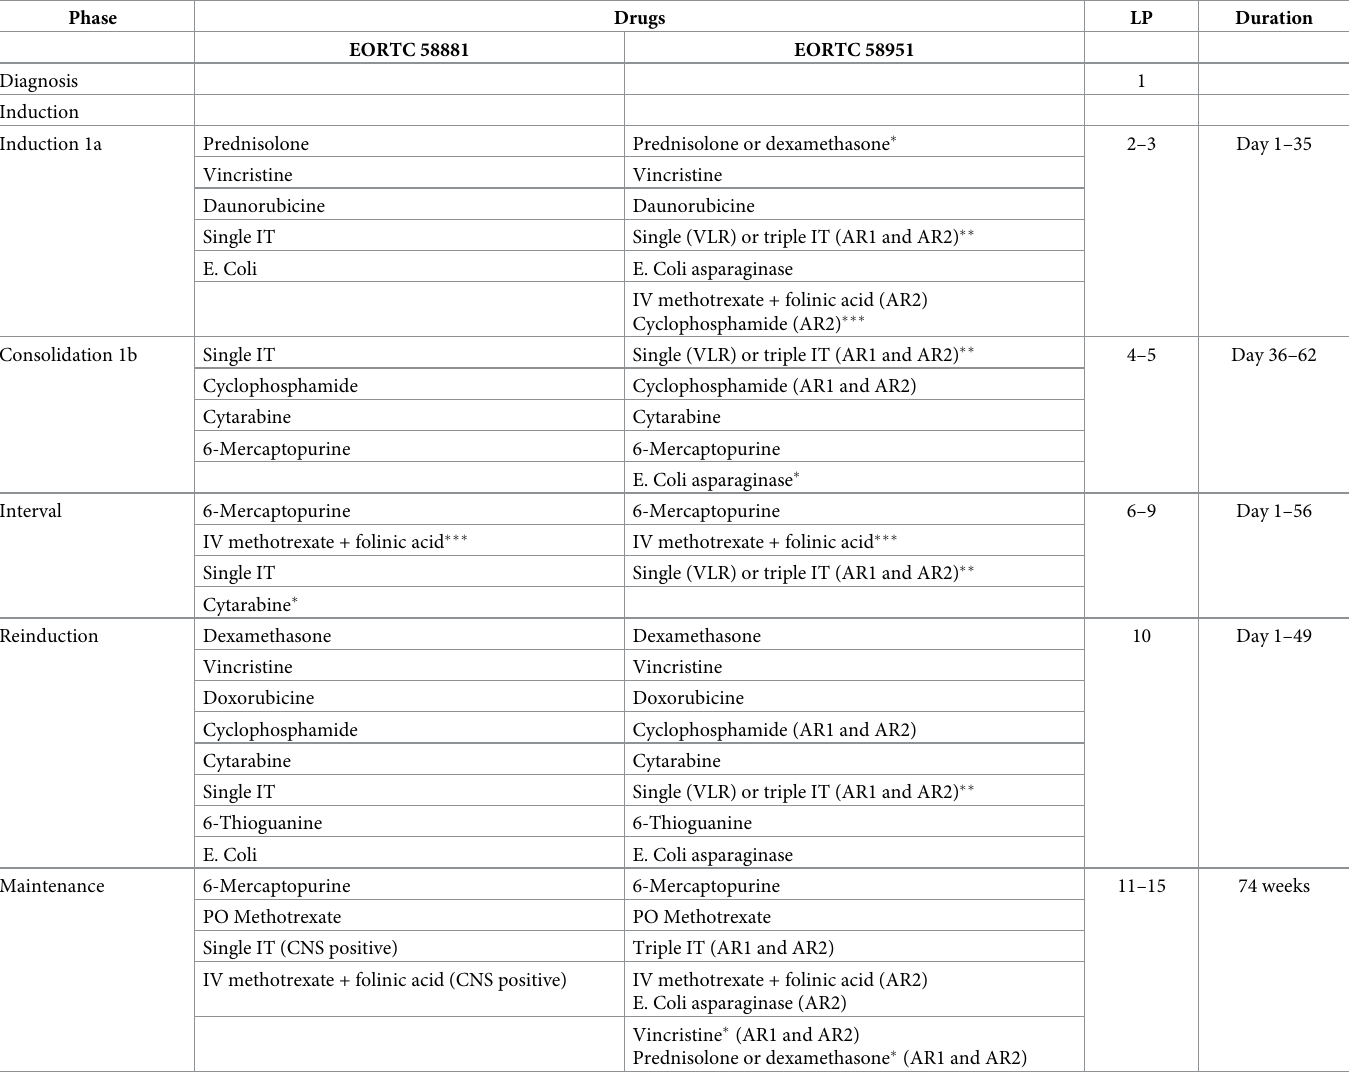
Table 3. Treatment schedules slightly differ between protocols EORTC 58881 and